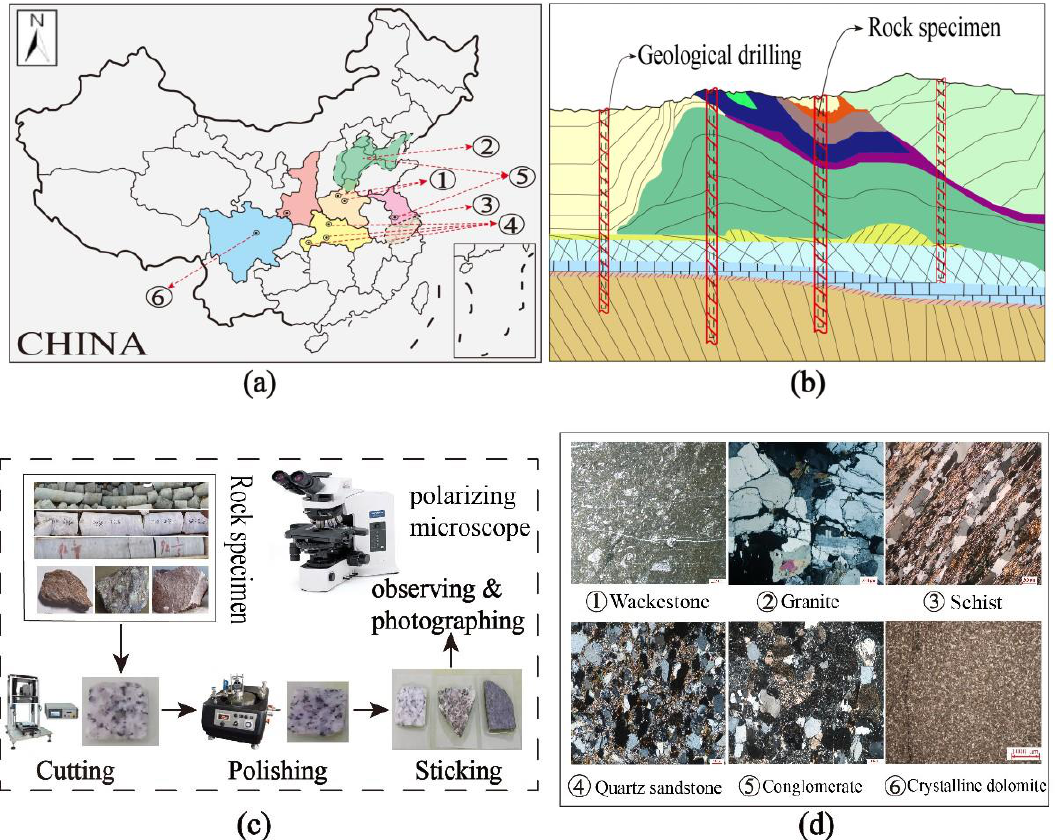
Figure 1. The sites of rock samples and the production process of rock thin section images; ( a ) Rock sample acquisition area; ( b ) Lithological map of different stratum; ( c ) Manufacturing process of rock thin sections; ( d ) Rock thin section image set.